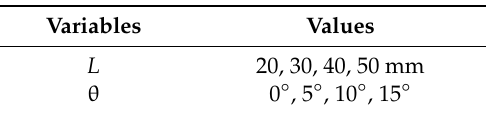
Table 3. Values of L and θ